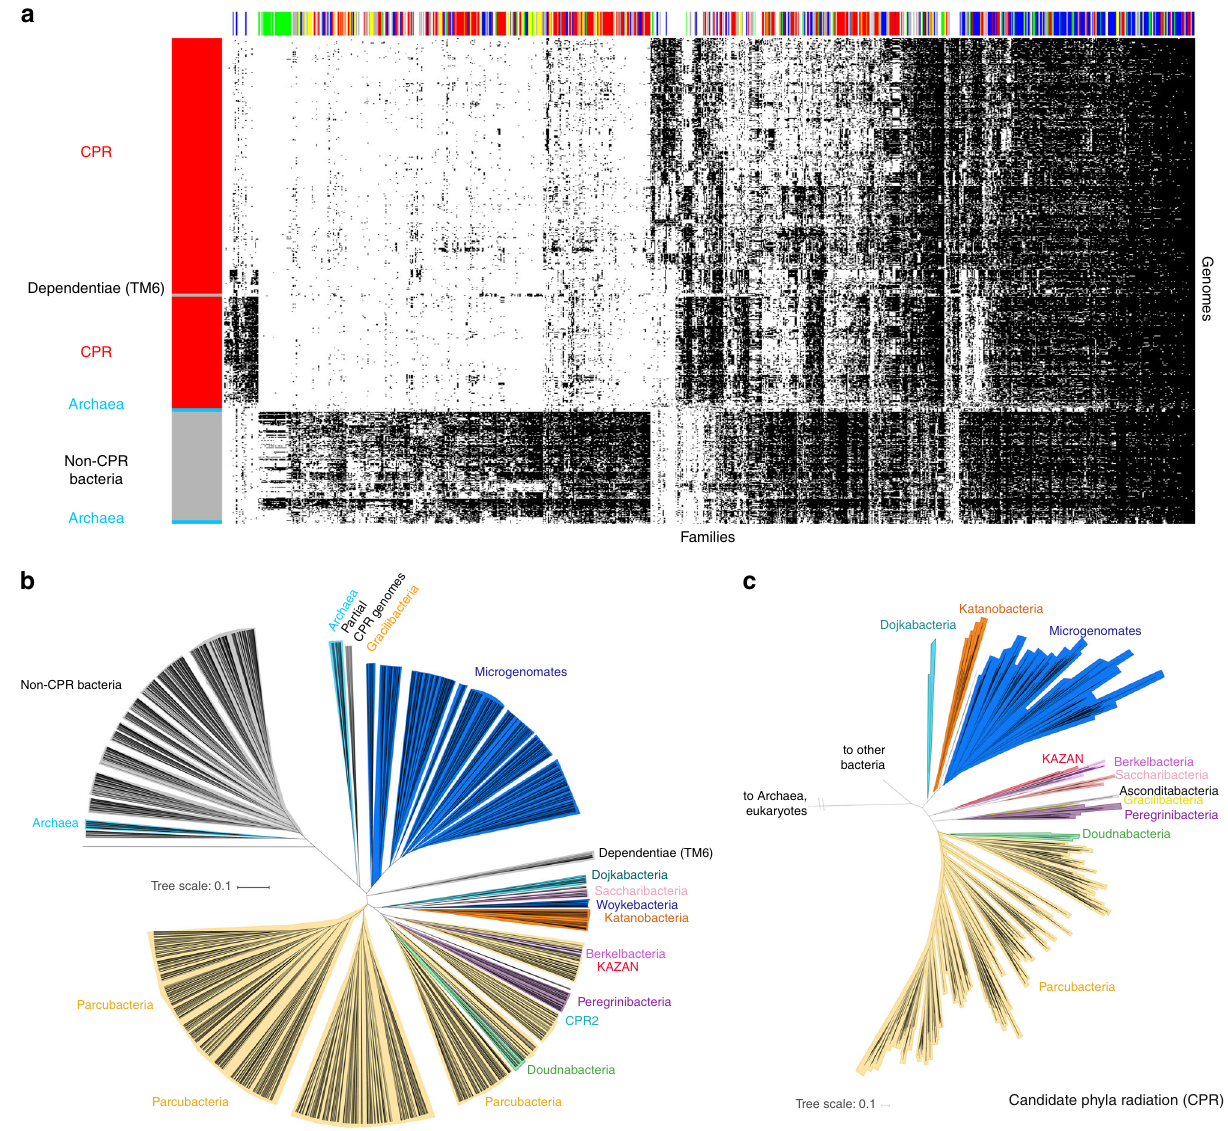
Fig. 3 The distribution of 921 widely distributed protein families across the 2890 genomes. a The distribution of 921 widely distributed protein families (columns) in 2890 genomes (rows) from CPR bacteria (red), non-CPR bacteria (gray), and a few archaea (light blue) in a reference set with extensive sampling of genomes from metagenomes (thus including sequences from many candidate phyla). Data are clustered based on the presence (black)/ absence (white) pro fi les (Jaccard distance, complete linkage). Only draft-quality and non-redundant genomes were used. The colored top bar corresponds to the functional category of families (Metabolism: red, Genetic Information Processing: blue, Cellular Processes: green, Environmental Information Processing: yellow, Organismal systems: orange, Unclassi fi ed: gray, Unknown: white). b Tree resulting from the hierarchical clustering of the genomes based on the distributions of proteins families in panel a . c A phylogenetic tree of the CPR genomes present in the dataset. The maximum-likelihood tree was calculated based on the concatenation of 14 ribosomal proteins (L2, L3, L4, L5, L6, L14, L15, L18, L22, L24, S3, S8, S17, and S19) using